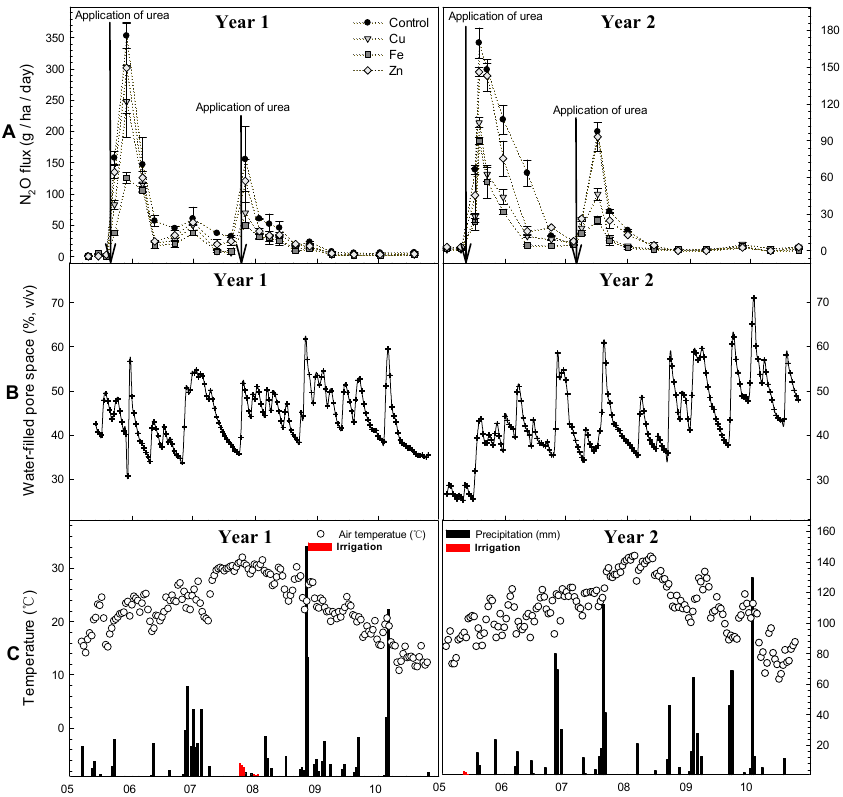
Figure 1. Daily N 2 O emission ( A ), water-filled pore space (WFPS) ( B ), air temperature, and precipi- tation ( C ) during the growing seasons in Years 1 and